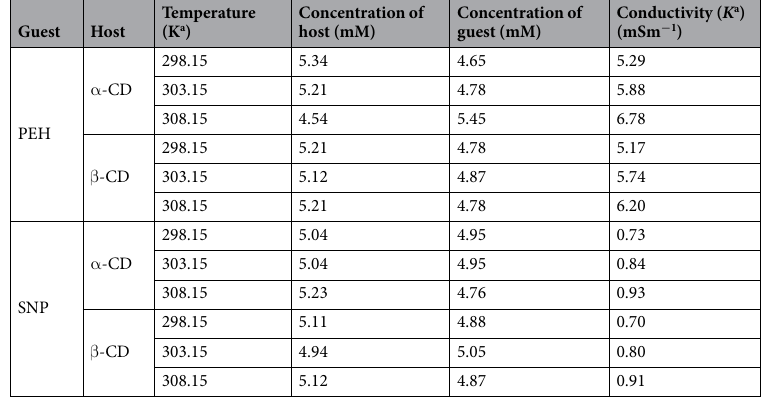
Table 2. Values of Conductivity ( κ ) at the Break Point with Corresponding Concentrations of DGs and CDs at 298.15 K a to 308.15 K a . a Standard uncertainties (u): temperature u(T) = ± 0.01 K, conductivity: u( κ ) = ± 0.01 mSm − 1 .